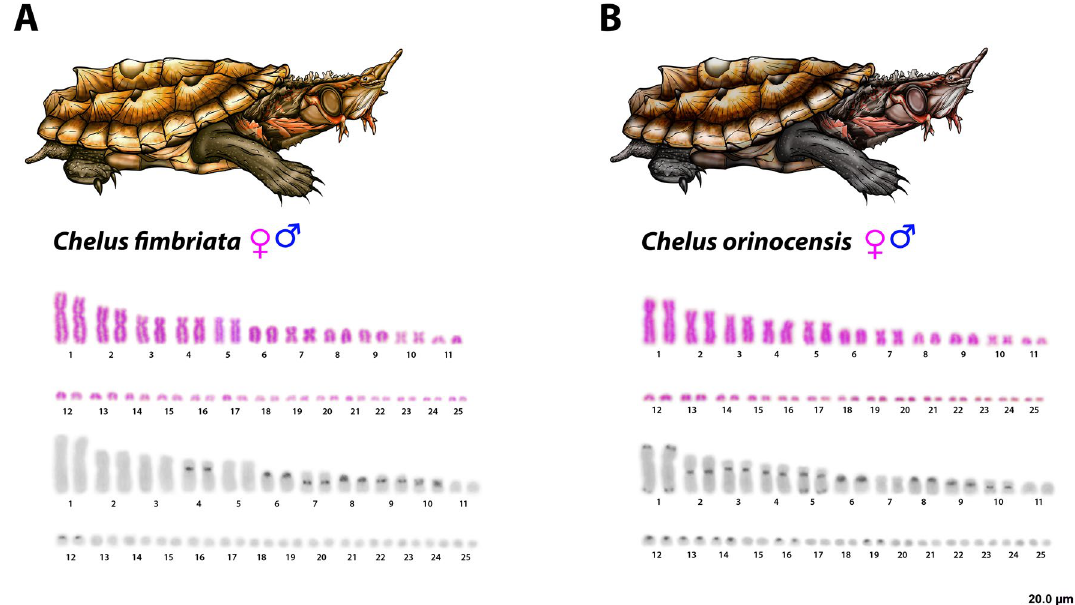
Figure 1. Karyotypes of males and females of Chelus fimbriata ( A ) and Chelus orinocensis ( B ) in Giemsa- staining and C-banding ( C , D ). Bar = 20 µm. Since male and female karyotypes are identical in morphology and in C-banding pattern, we selected a representative male metaphase to illustrate the